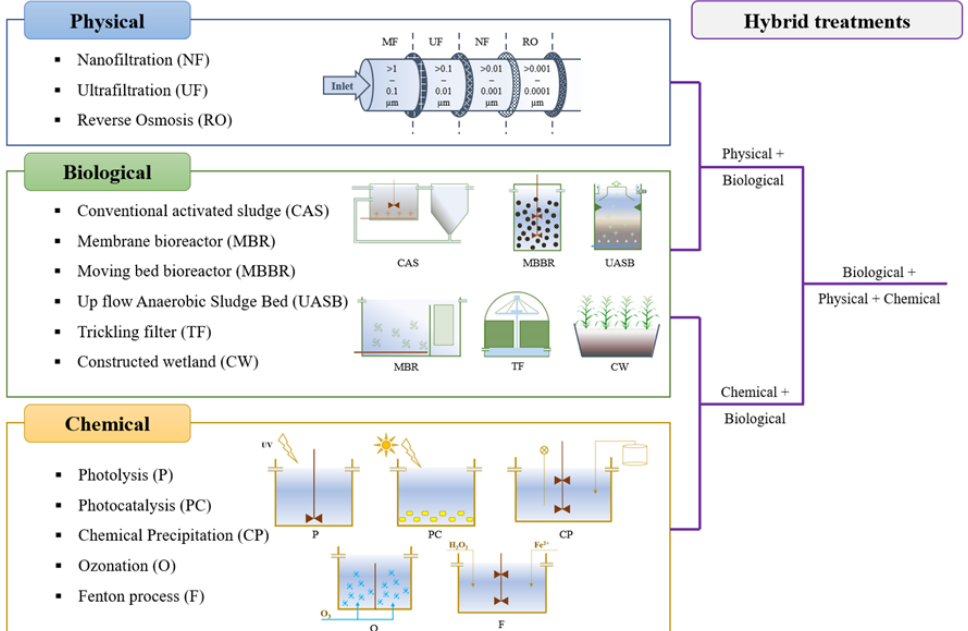
Figure 3. Main treatment methods for EOC removal from municipal wastewater.